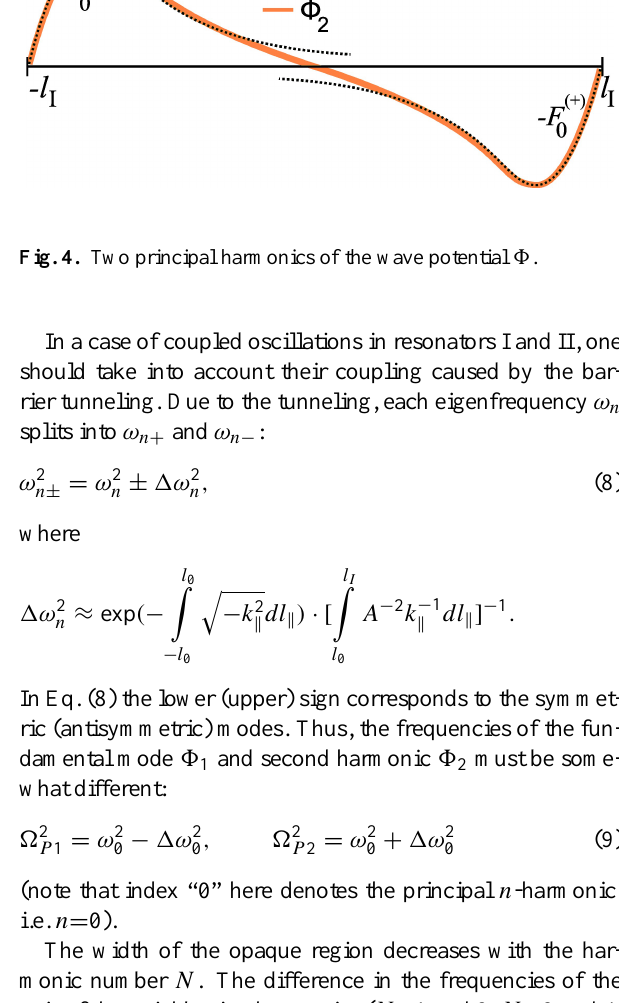
Fig. 3. Two principal harmonics of the functions F (